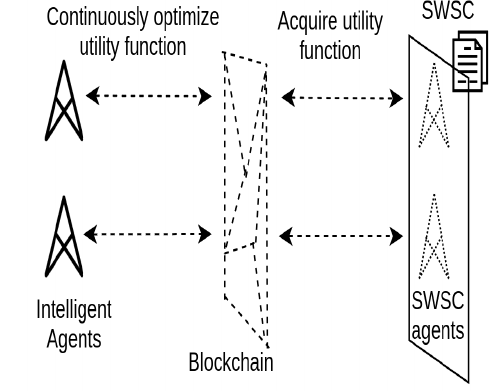
Figure 3. Interaction between intelligent agents and SWSC